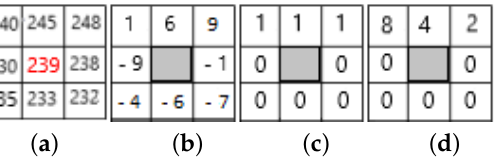
Figure 5. Example of LBP code computation for a pixel: LBP code is 2 + 4 + 8 = 14 in this case. ( a ) pixel neighbourhood; g c = 239; ( b ) after thresholding; ( c ) pattern: 00001110; ( d ) code =